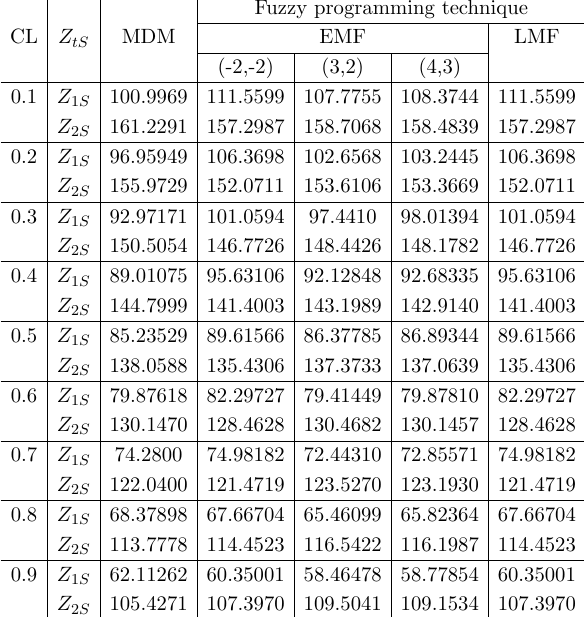
Table 4. Objective values obtained during the sensitivity analysis of the OV Model-6 with FPT.